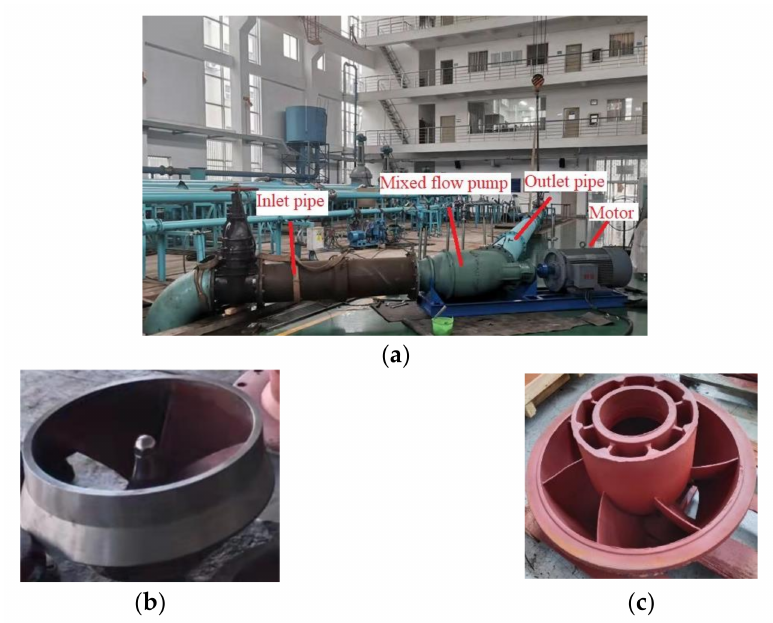
Figure 17. Experimental measurement. ( a ) Test rig. ( b ) Impeller. ( c ) Diffuser. The performance curves of the initial and optimized schemes are compared in Figure 18.